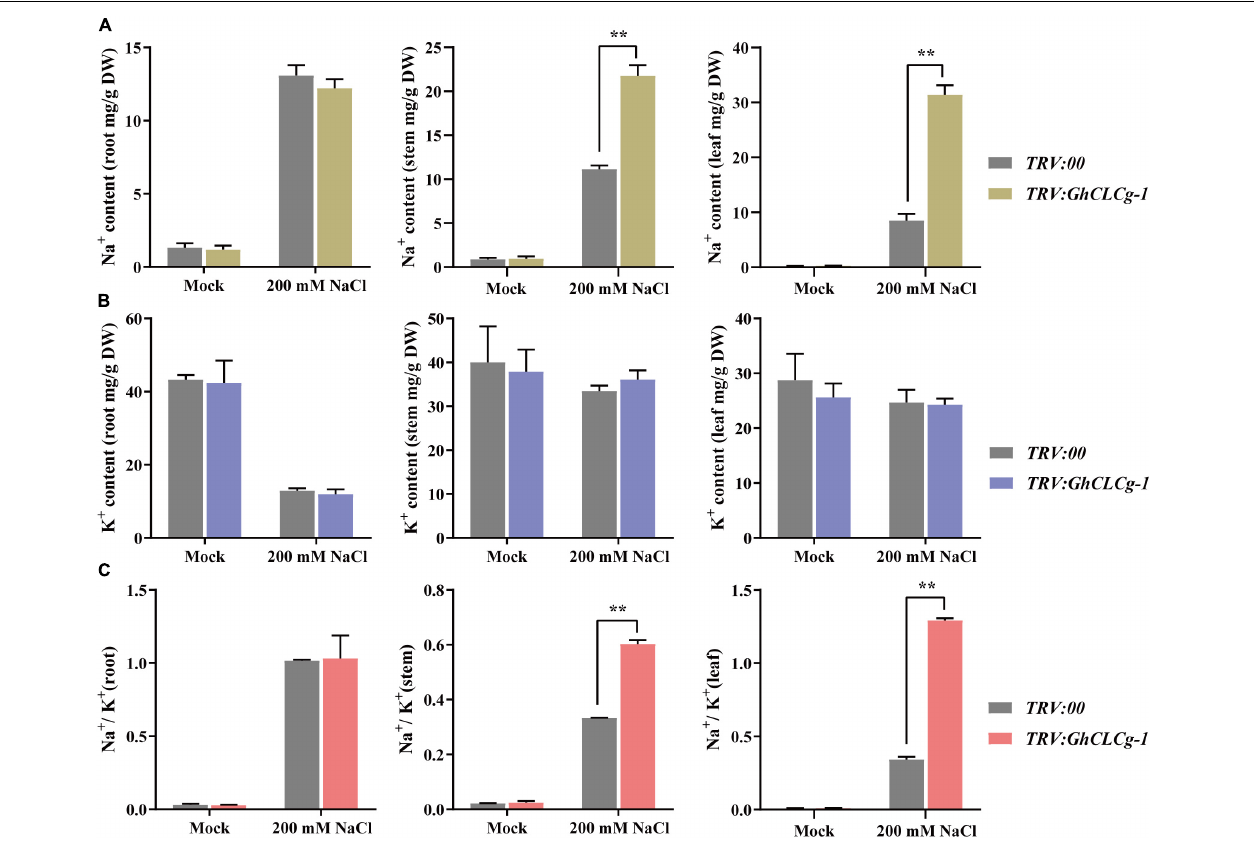
FIGURE 8 | Cation contents of TRV:00 and TRV:GhCLCg-1 plants. (A) Na + contents, (B) K + contents, and (C) Na + /K + ratio of TRV:00 and TRV:GhCLCg-1 plants with salt treated for 3 days. Data are presented as the mean ± standard deviation (SD) of three biological replicates ( ∗∗ p < 0.01, t